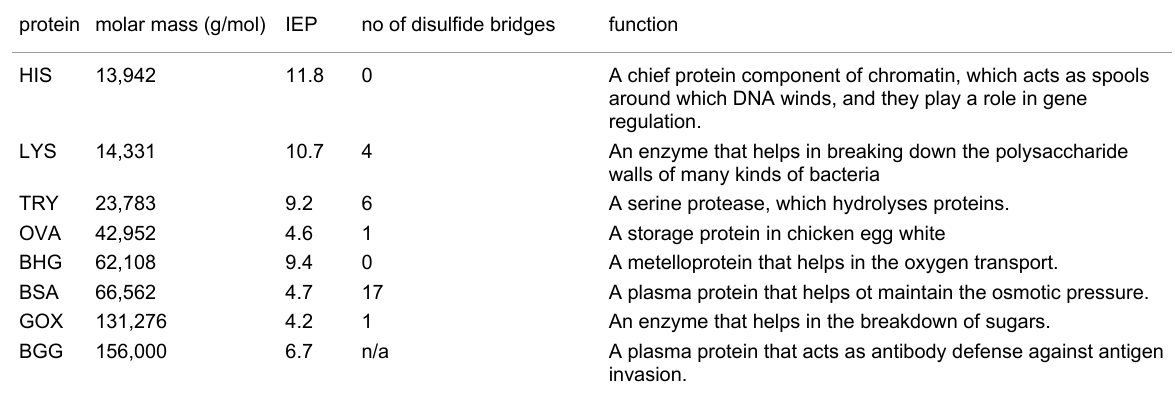
Table 1: Molar mass, isoelectric point and function of different proteins. protein molar mass (g/mol) IEP